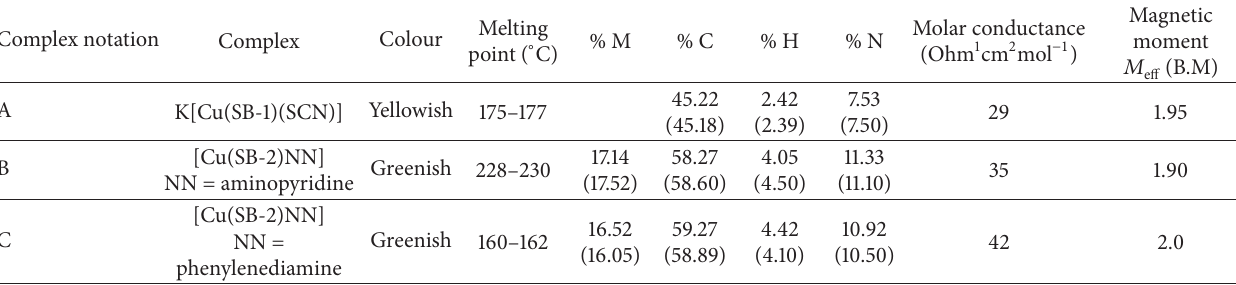
Table 1: Analytical data a and physical properties.